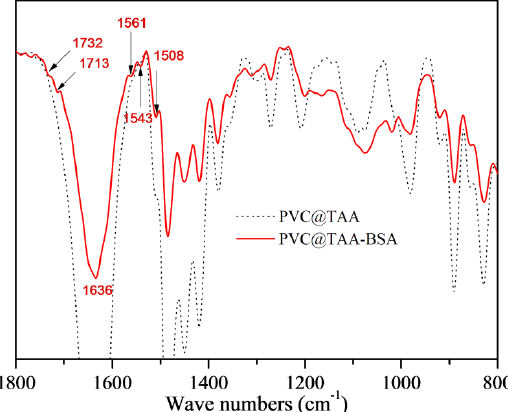
Figure 4. FT − IR spectra of PVC@TAA and PVC@TAA − BSA nanoparticles.